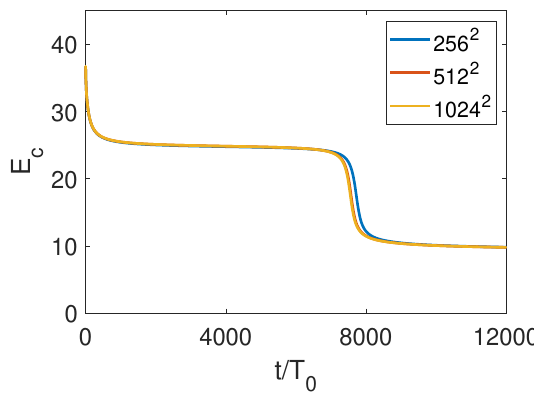
Figure 17. Convergence study with different spatial resolutions. The lifetime decreases slightly as the resolution increases. We use a 512 2 lattice to survey the lifespans of the CSQ, and the uncertainty due to the lattice resolution is within 1%. The physical box size is 102 . 4 2 and thus d x = 0 . 2